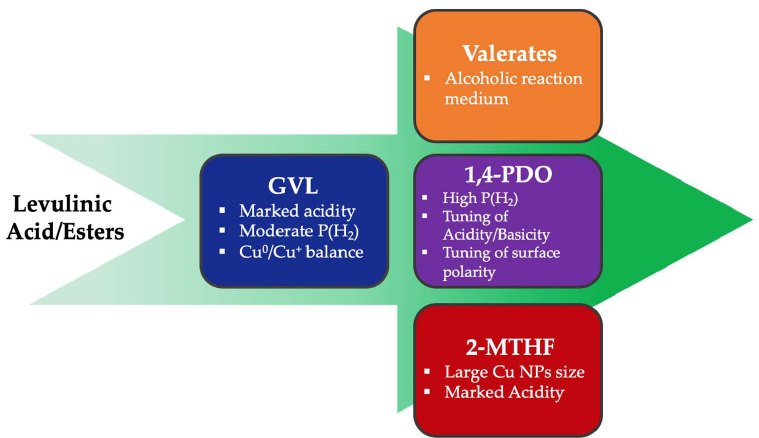
Figure 2. Products obtainable from LA/LEs by varying catalyst properties and reaction